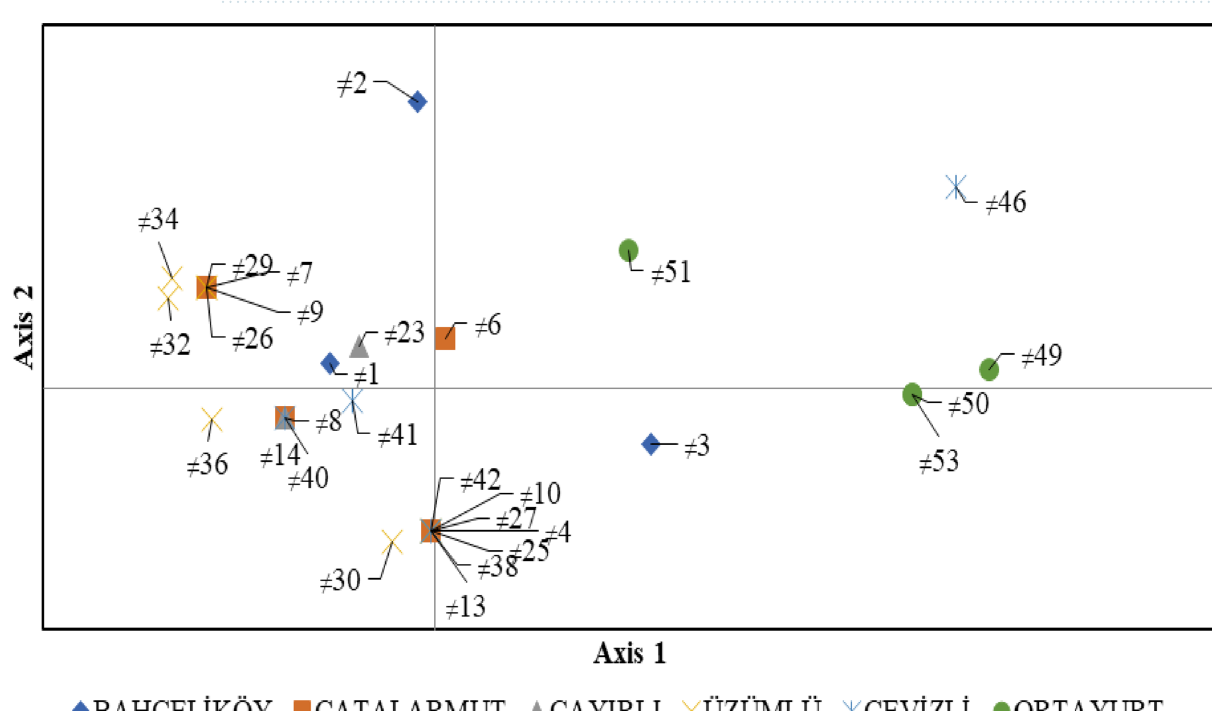
Figure 2. PCA created using the SSR marker and separated on 2-dimensional